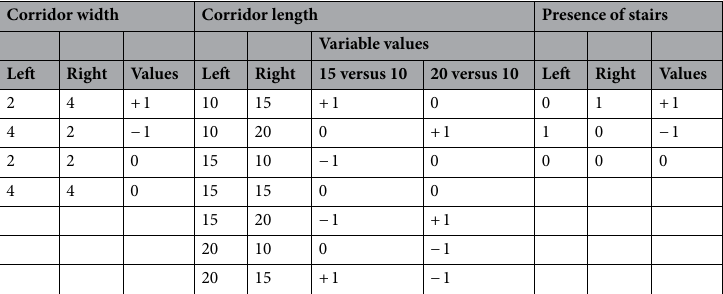
Table 2. Dummy variable coding using the Bradley–Terry